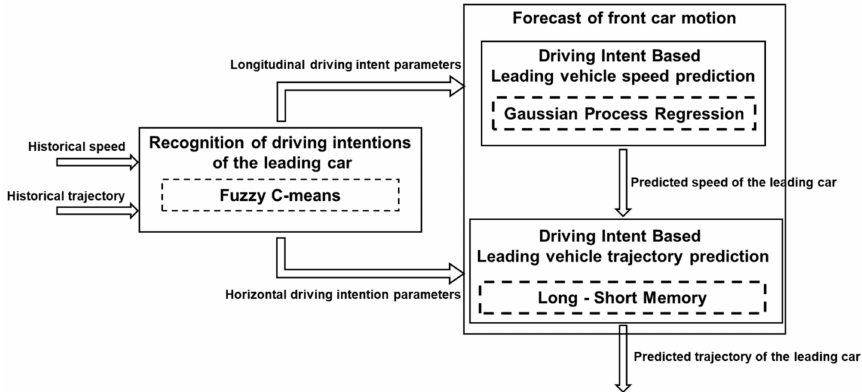
Figure 1. Structure of the leading vehicle motion prediction